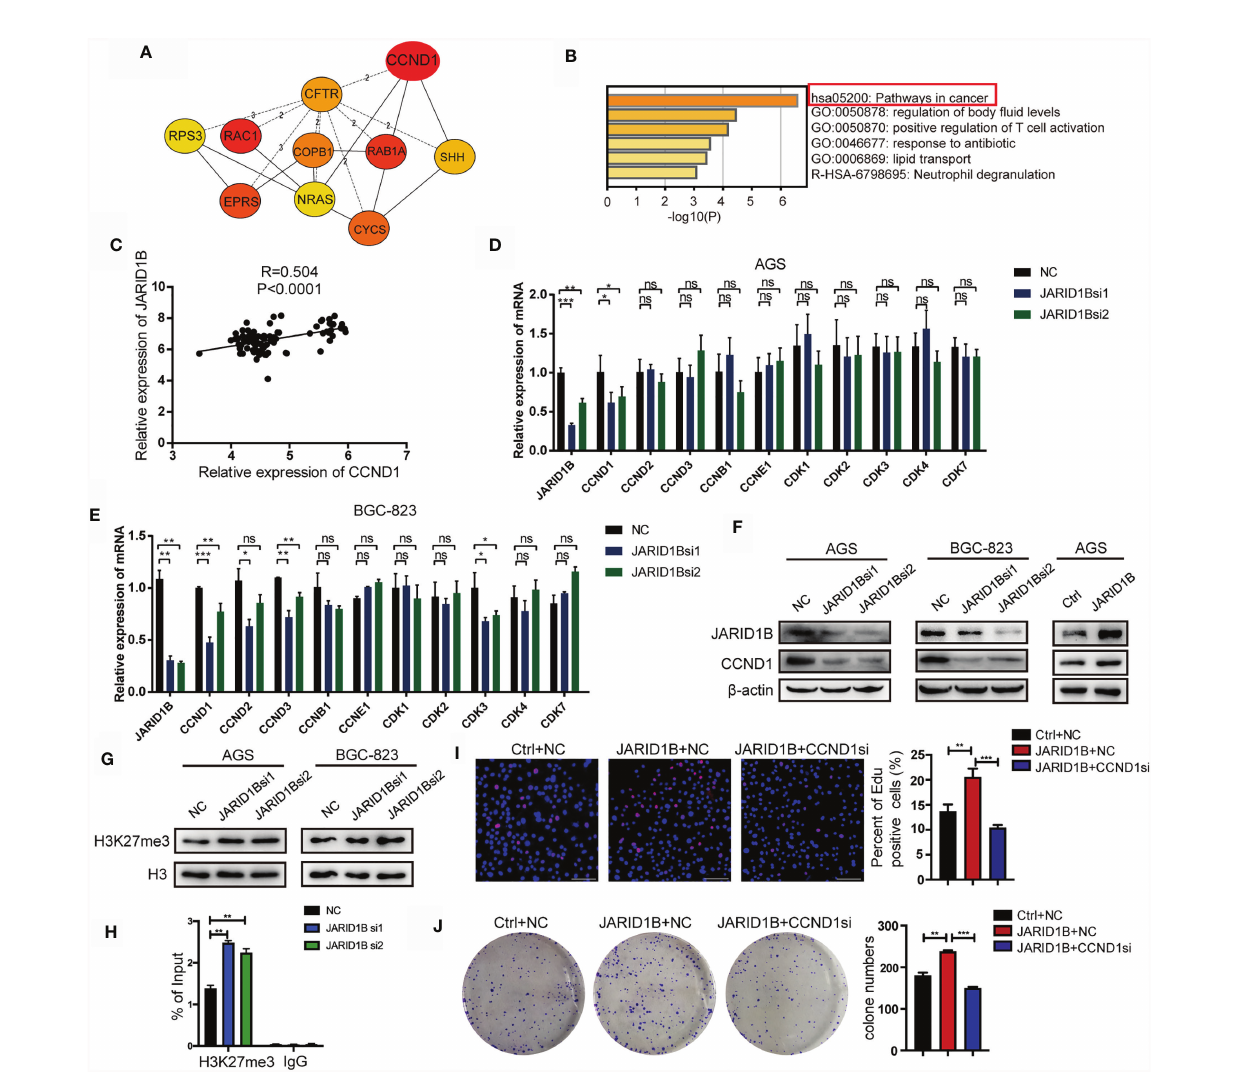
FIGURE 7 | JARID1B promotes the expression of CCND1 in gastric cancer (GC) cells. (A) The upregulated genes that are positively related to JARID1B expression in GSE54129 of GC. (B) The biological function and pathway enrichment analysis with the Metascape. (C) The Gene Expression Omnibus (GEO) database (GSE63089) analysis showed that there was a signi fi cant positive correlation between JARID1B and CCND1 in 45 pairs of GC and corresponding adjacent normal tissues. (D, E) RT-PCR was used to detect the expression of proliferation-related genes in AGS and BGC-823 transfected with JARID1B siRNA. *P < 0.05; **P < 0.01; ***P < 0.001, NS, not statistically signi fi cant. (Student ’ s t-test). (F) Western blot assay was performed to detect CCND1 expression in AGS and BGC-823 after transfection with JARID1B siRNA. (G) The levels of H3K27me3 after JARID1B knockdown was tested by Western blot. (H) Chromatin immunoprecipitation (ChIP) assays were performed in JARID1B knockdown AGS cells. (I, J) Colony formation assays and EdU staining were used to test the role of CCND1 in the proliferation of GC cells regulated by JARID1B. Scale bar, 100 m